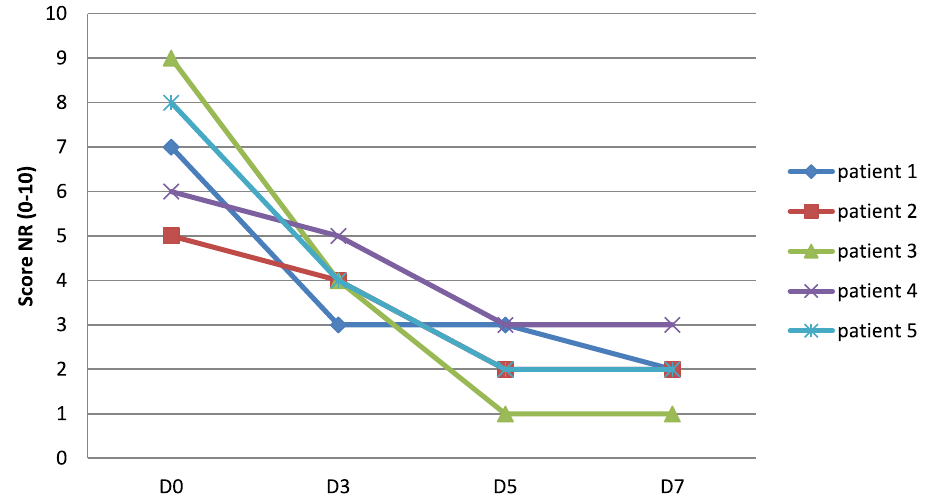
Fig. 1. Time course of the pain self-reported on a numeric rating scale at baseline (D0) and after 3, 5 and 7 days (D3, D5, D7). Table III. Characteristics of the BMS patients 3 months after MB treatment. VAS = Visual Analogic Scale (VAS). USF/SSF = Unstimulated and Stimulated Salivary